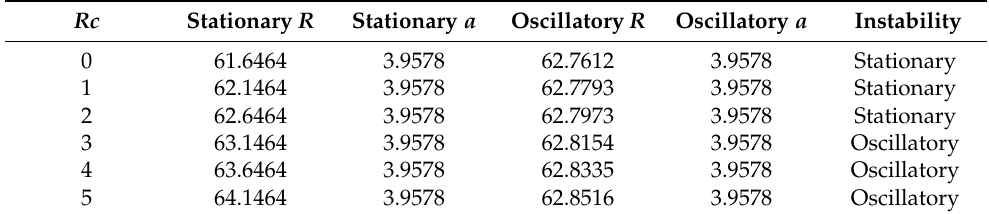
Table 1. Critical stationary and oscillatory Rayleigh numbers for different values of Rc and the fixed values of κ r = 1, Ta = 5, and S = 0.5.